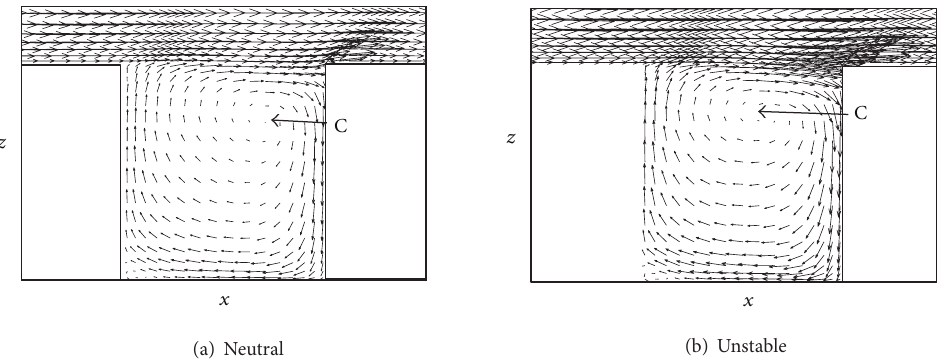
Figure 4: Normalized velocity vector (𝑈/𝑈 𝑓 , 𝑊/𝑈 𝑓 ) on vertical planes through the middle of the